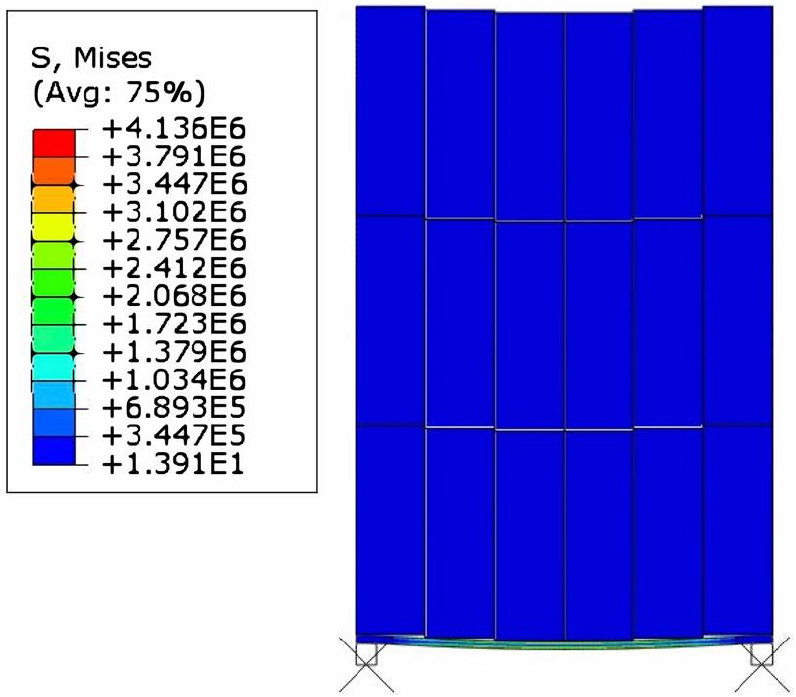
Figure 8. Plot of the equivalent Von Mises (MPa) stress of the unit load segment under a 6-column payload. Table 8. Changes in deflection and maximum equivalent stresses from uniformly distributed loading to discrete number of boxes.